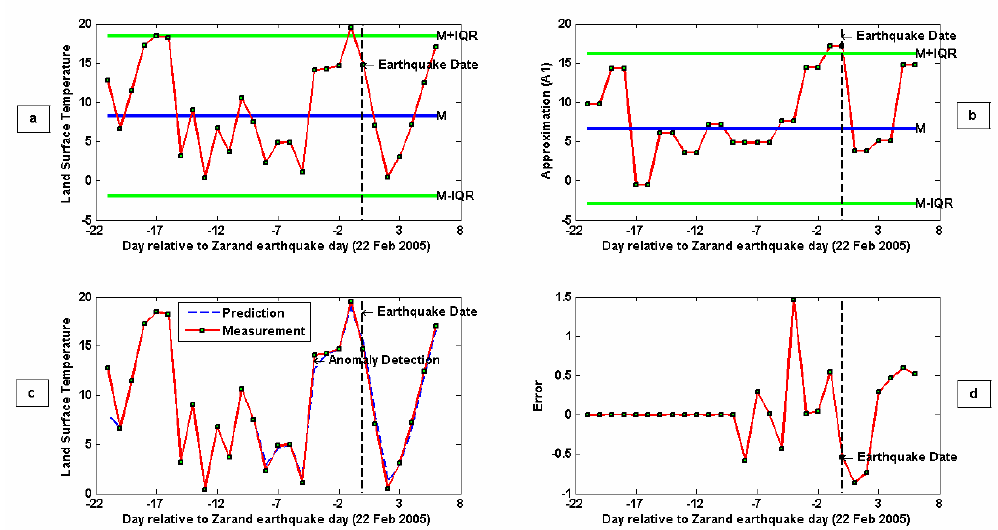
Fig. 5. Same as Fig. 4 but for the Zarand earthquake (22 February 2005) from 1 February to 28 February 2005.